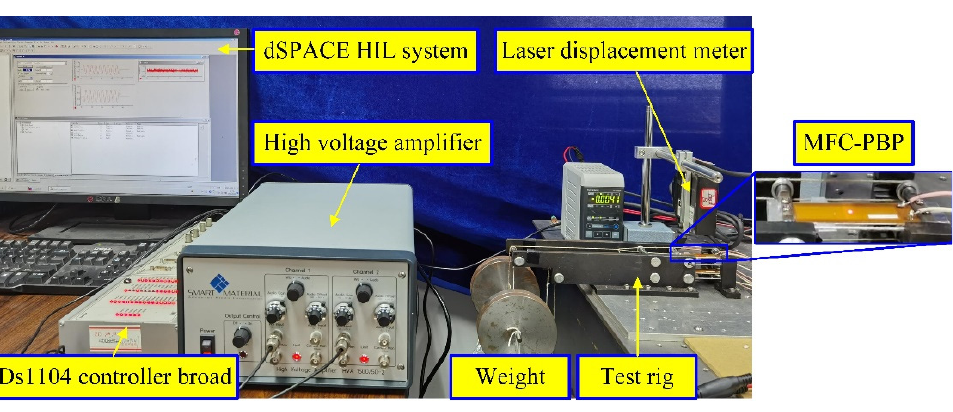
Figure 3. Test platform for MFC-PBP.